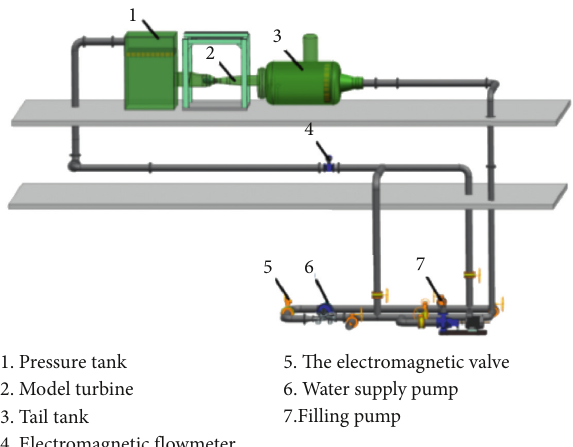
Figure 9: Schematic diagram of the three-dimensional model of the multifunctional test stand.